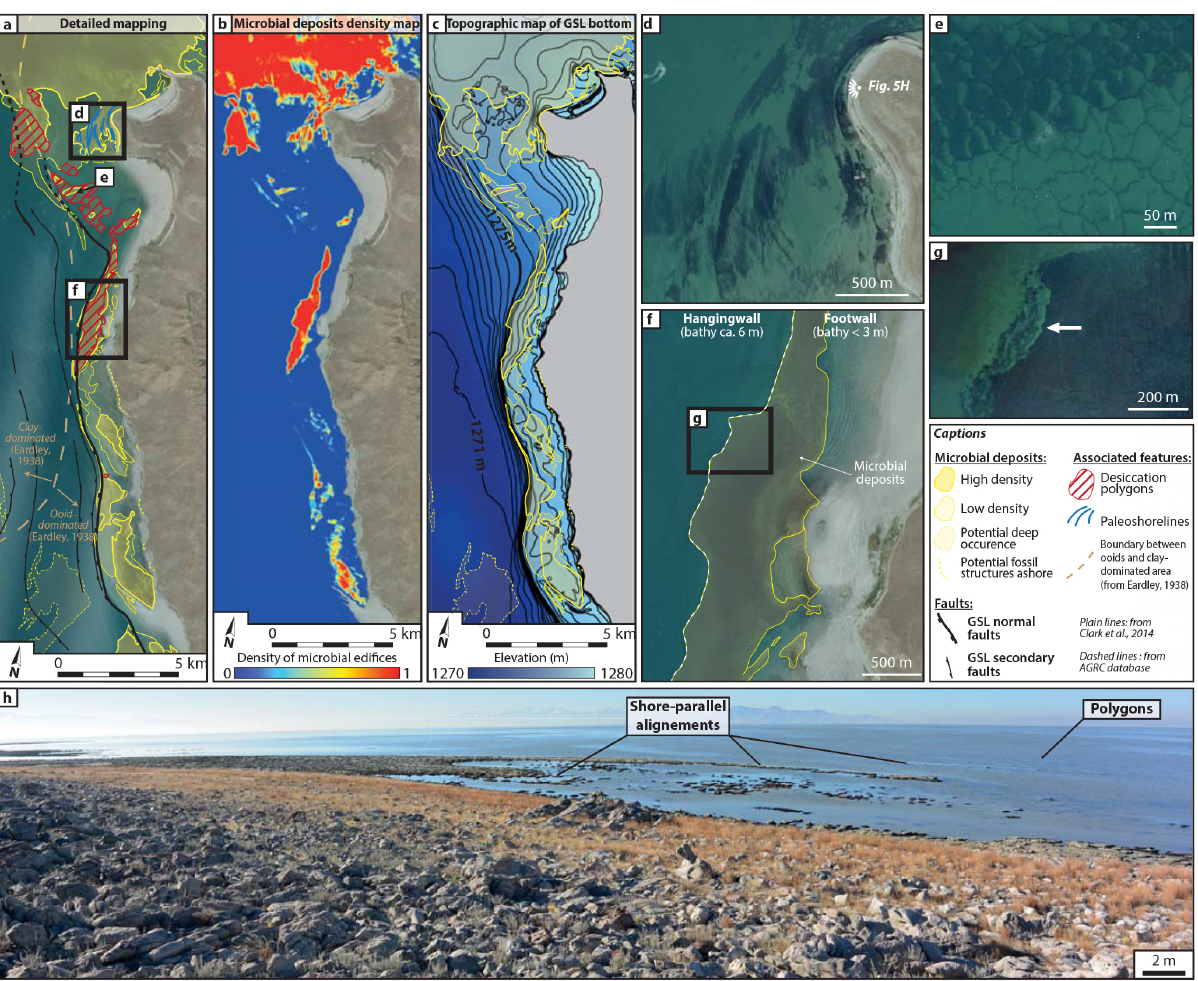
Figure 5. Detailed maps of the western side of Antelope Island. (a) Distribution and organization of the microbial deposits and sedimentary structures (2014 NAIP 1m orthophotography). (b) Density map of the distribution of the microbial deposits. (c) Bathymetric map showing isopleths of 0.5m. (d) Details of the microbial alignments interpreted as paleoshorelines. (e) Details of the desiccation polygons. (f) GSL major normal fault and lower limit of the microbial deposits (white dashed line); the microbial deposits are present in the footwall (yellow polygon) but not observed on the hanging wall. (g) Details of a lens-shaped detachment of the microbial deposits resulting from gliding (white arrow). (h) Photographs taken from the heights of the NW area of Antelope Island of the shore-parallel alignments of the microbial deposits on the